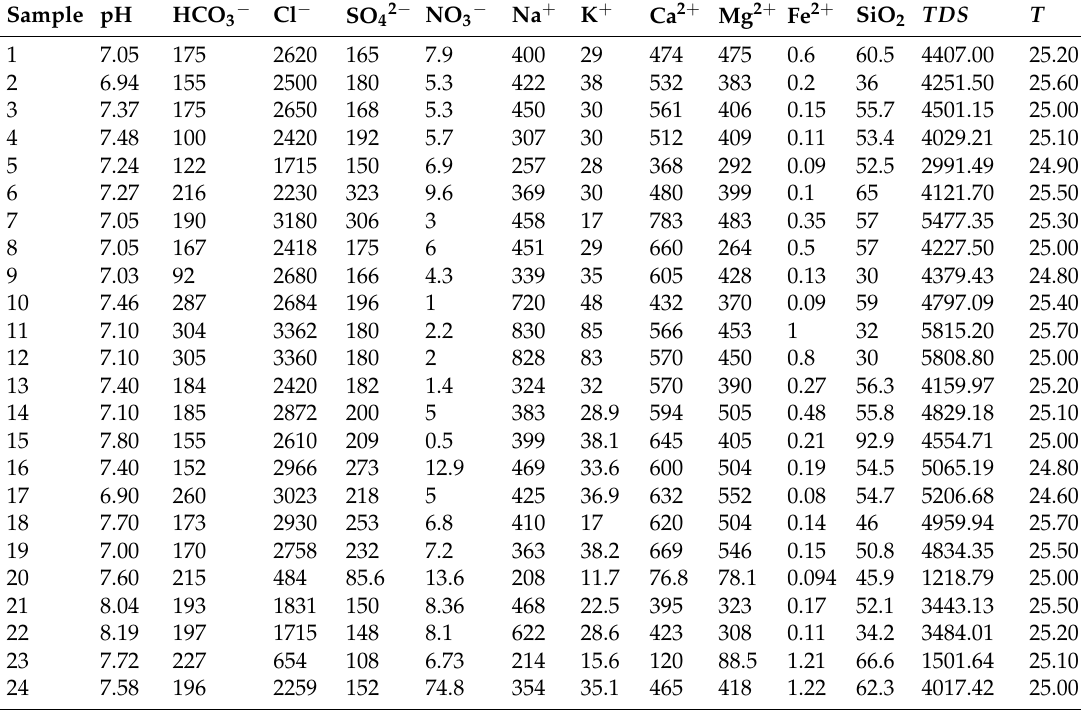
Table 1. Feed water inorganic composition in mg L − 1